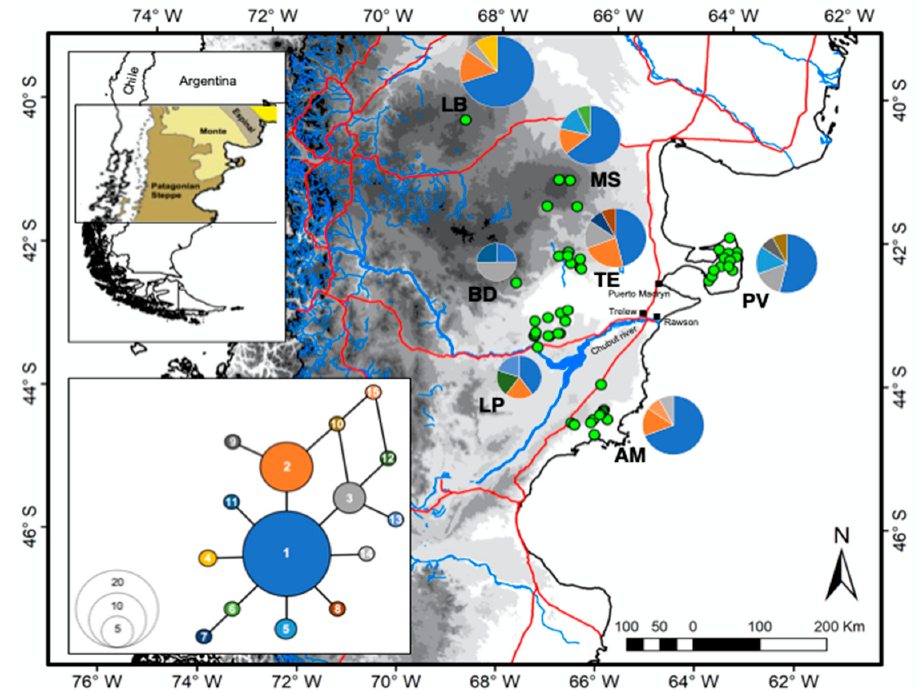
Figure 1. Map of northern Patagonia, with the locations where the individual samples of Lama guanicoe used in the analyses were collected represented by green circles. Roads are represented by orange lines and rivers and water bodies by blue lines. Each of the seven locations indicates the relative proportion of each of the 15 haplotypes. Each unique haplotype is represented by a unique color, and the relative proportion of each is depicted in pie charts for each locality. The relative frequency of each haplotype and their phylogenetic relationships are depicted in the insert. The localities’ names are LB = Loma Blanca; MS = Meseta Somuncura; TE = Telsen; PV = Península Valdés; BD = Bajada del Diablo; LP = Las Plumas; AM = Ameghino.